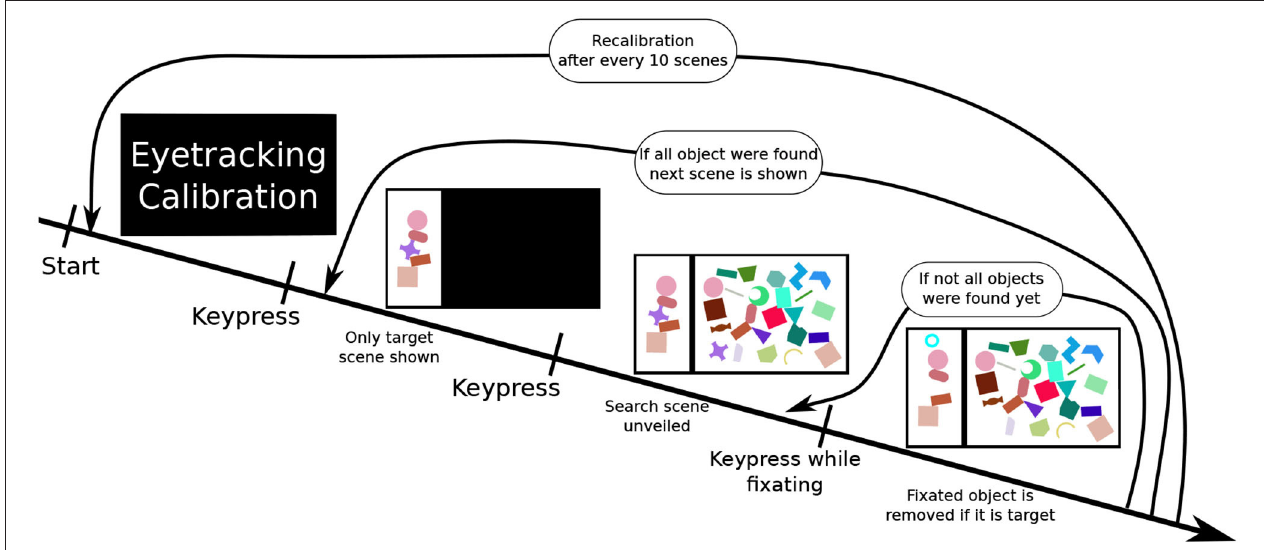
FIGURE 2 | The experiment procedure: First, a calibration of the eyetracker is performed. Once completed, the participant performs a keyboard press showing a scene. At first, only the target scene is shown. Upon performing another keyboard input, the search scene is revealed. The fourth image illustrates a correct selection, the participant performed pressing space while fixating on a target object in the search scene. This removes the shape from both scenes (here the purple cross) and displaying a feedback image (cyan circle) in the upper left corner. This process is repeated until all target objects are removed. After this, the next search scene is